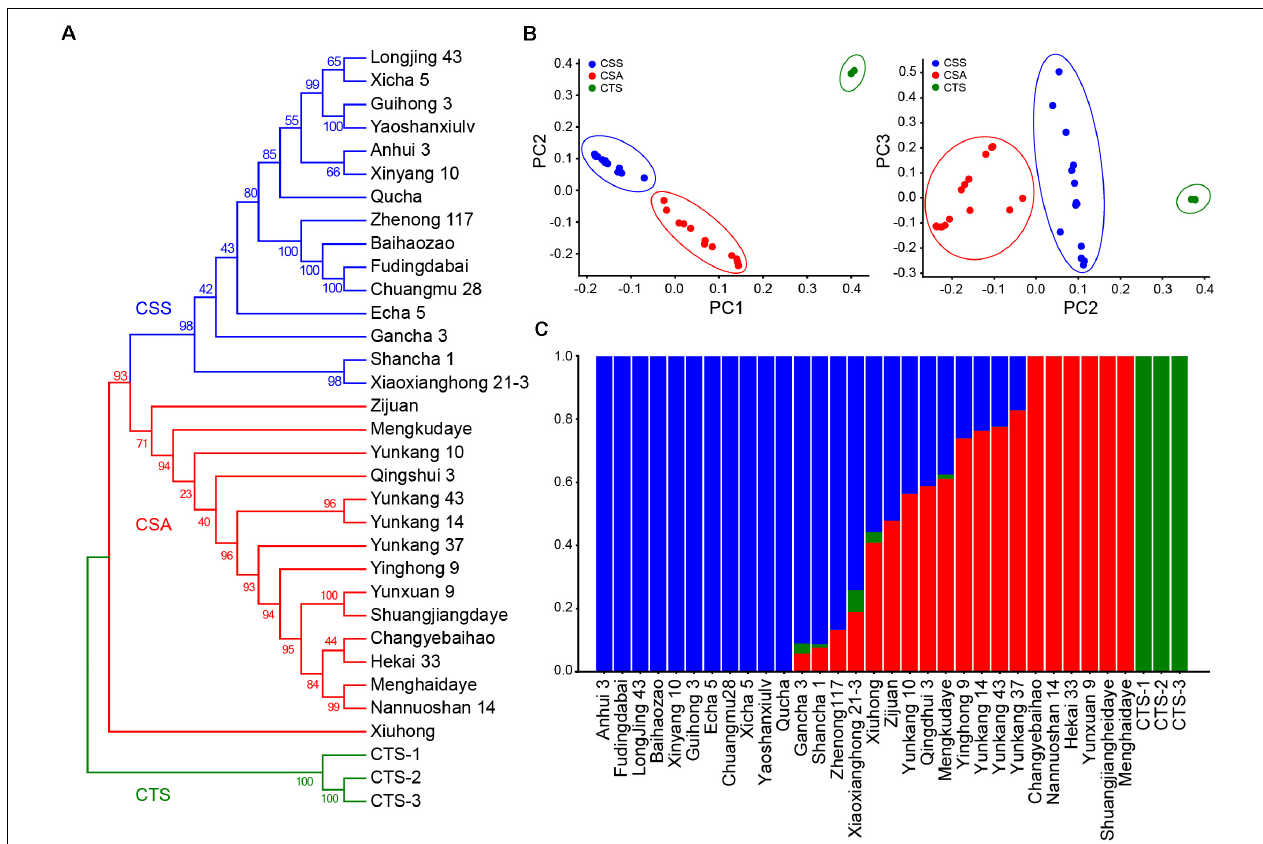
FIGURE 2 | Phylogenetic, population stratification analysis, and Principal Component Analyses (PCA) based on 5,52,750 SNPs. (A) Neighbor-Joining phylogenetic tree of 33 tea germplasms. (B) PCA analysis for 33 tea samples. (C) Population stratification based on admixture analysis when K set as